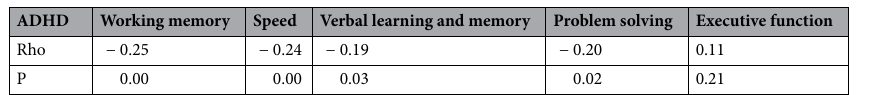
Table 3. Spearman’s correlation between self-reported ADHD symptoms and neuropsychological test scores. The participants neuropsychological test scores within five cognitive domains were correlated to their ADHD T scores. Correlation is corrected for age and education using standardised residuals. The data are Spearman’s correlation coefficients (Rho) and their corresponding p values.